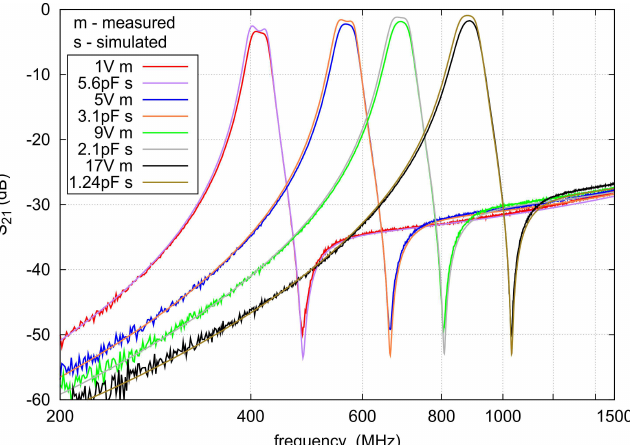
Figure 13. Measured and simulated s 21 of the proposed tunable bandpass filter for the selected control voltages.